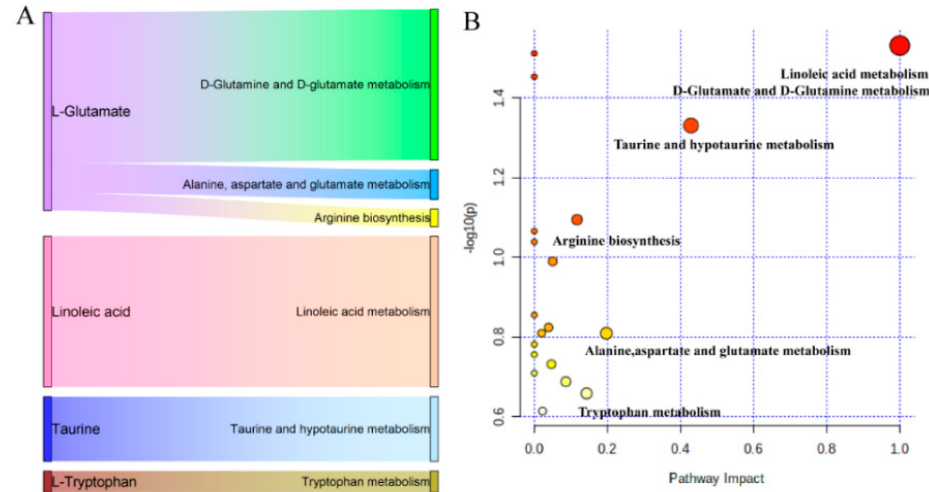
Figure 8. ( A ) Sankey plot showcasing key metabolites involved in significant enriched pathways. The dot plot shows the impact score and total number of metabolites in each enriched pathway (false discovery rate-adjusted p < 0.05). ( B ) Metabolic pathway analysis. x -axis, pathway impact; y -axis, − log10 ( p ). Circles represent the pathway impact score. Darker circles indicate more significant changes in metabolites in the corresponding pathway. The size of the circle corresponds to the metabolite counts in the corresponding pathway.